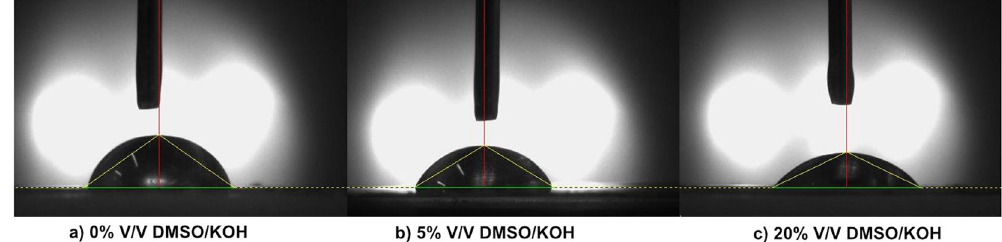
Figure 7. Results of sessile drop test of different electrolytes containing 0%, 5%, 20% v/v DMSO/KOH electrolytes on the zinc